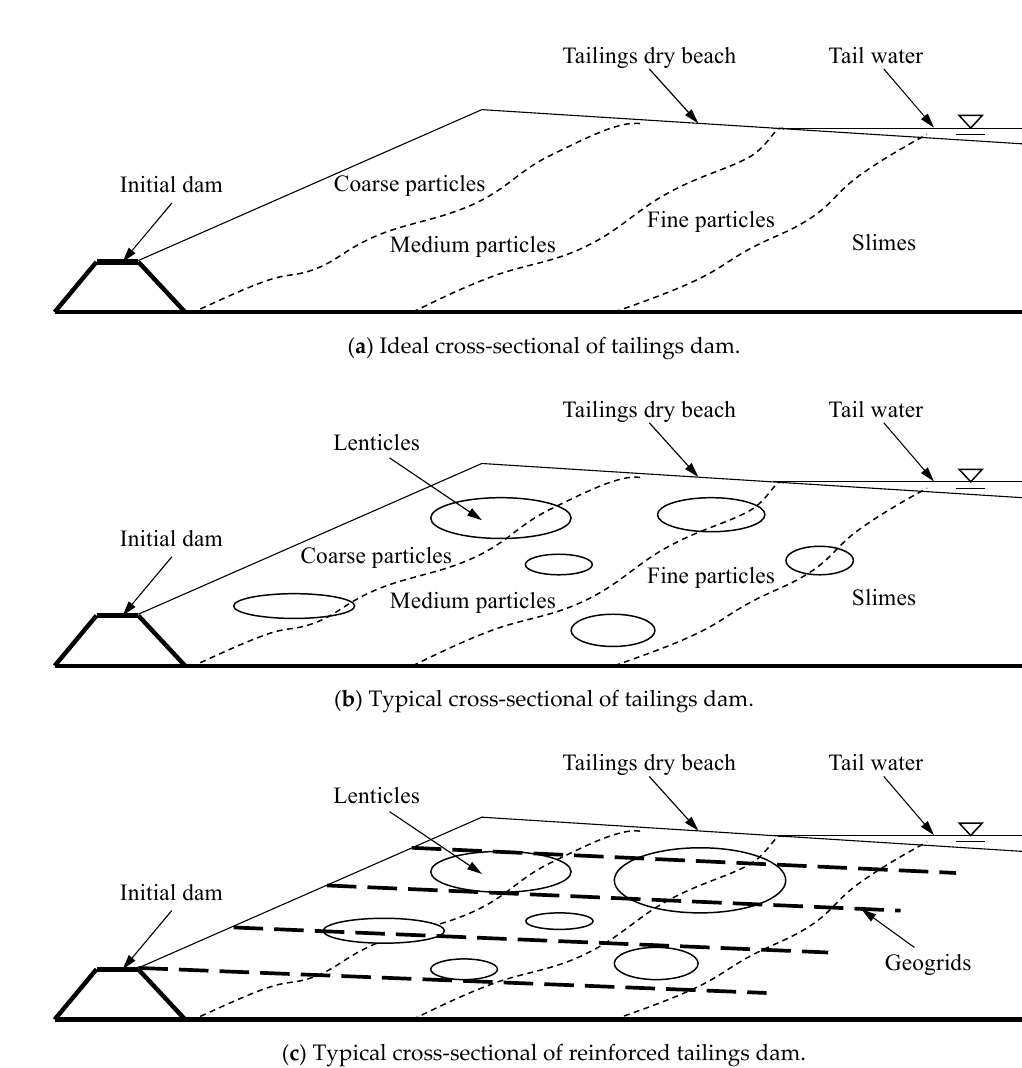
Figure 1. Cross ‐ section of tailings dam constructed by the upstream method. ( a ) Ideal Figure 1. Cross-section of tailings dam constructed by the upstream method. ( a ) Ideal cross-sectional of tailings dam, ( b ) cross ‐ sectional of tailings dam, ( b ) Typical cross ‐ sectional of tailings dam, ( c ) Typical Typical cross-sectional of tailings dam, ( c ) Typical cross-sectional of reinforced tailings cross ‐ sectional of reinforced tailings dam.